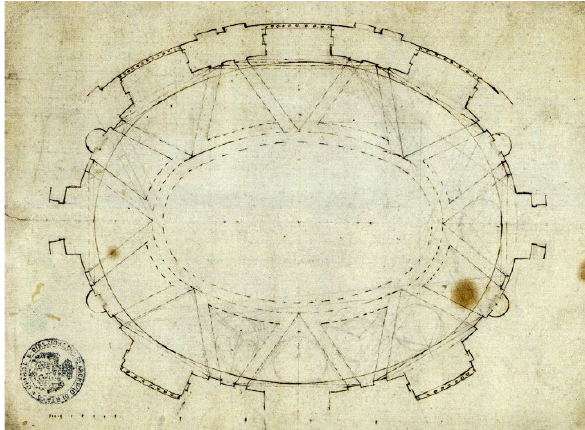
Figure 5. Study for the voult of the main hall of Palazzo